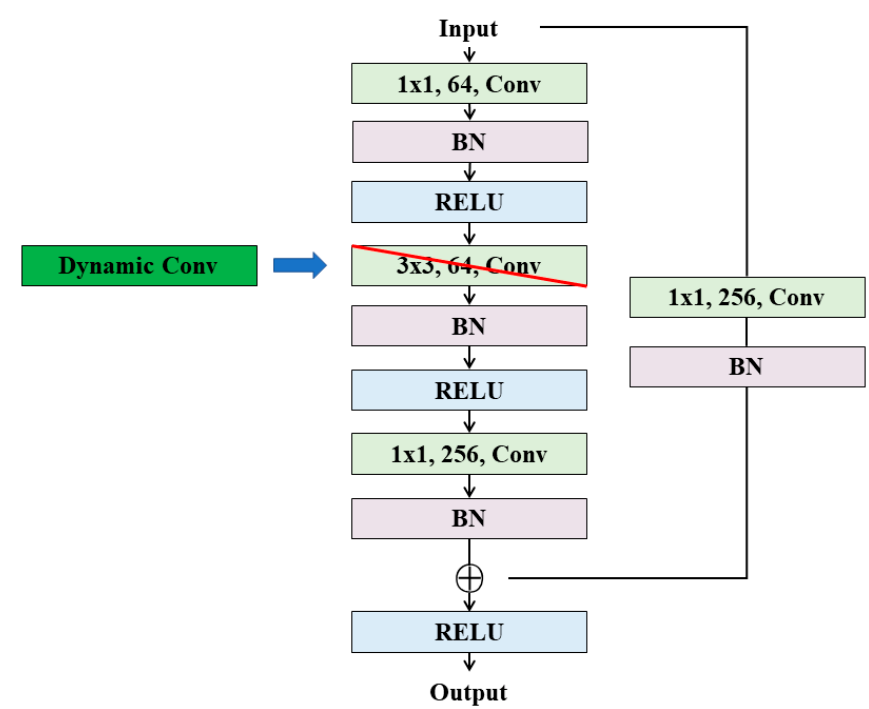
Figure 6. Replacing a 3 × 3 convolution with a dynamic convolution in Resnet50.